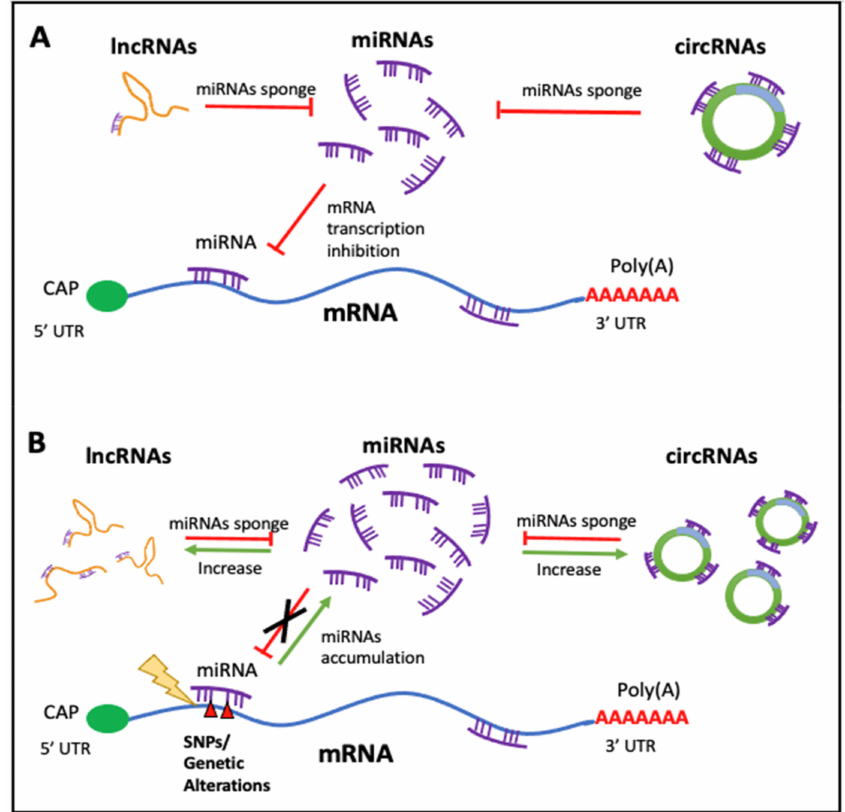
Figure 2. Regulatory feedback between ncRNAs. The interconnection existent among the main ncRNAs species involved in human diseases. ( A ) Regular interaction in a normal scenario (healthy cells). ( B ) When an alteration occurs (i.e., SNPs, mutation, expression alteration) there is an imbalance in the competing endogenous RNA (ceRNA) characteristic of many